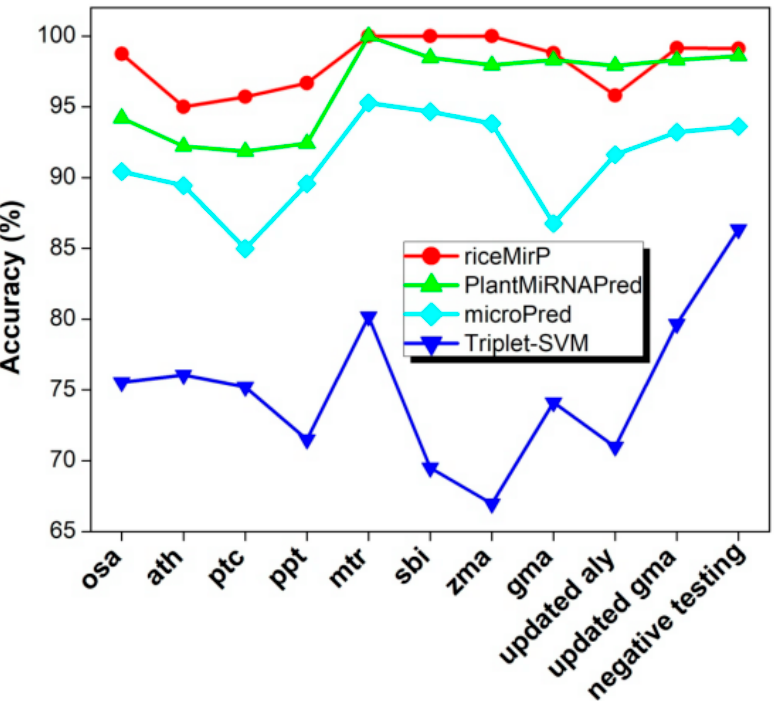
Figure 7. Comparison of riceMirP with triplet-support vector machine (SVM), microPred, and PlantMiRNAPred based on the training and testing datasets from PlantMiRNAPred. The classification results reported previously are directly used for comparison [24].